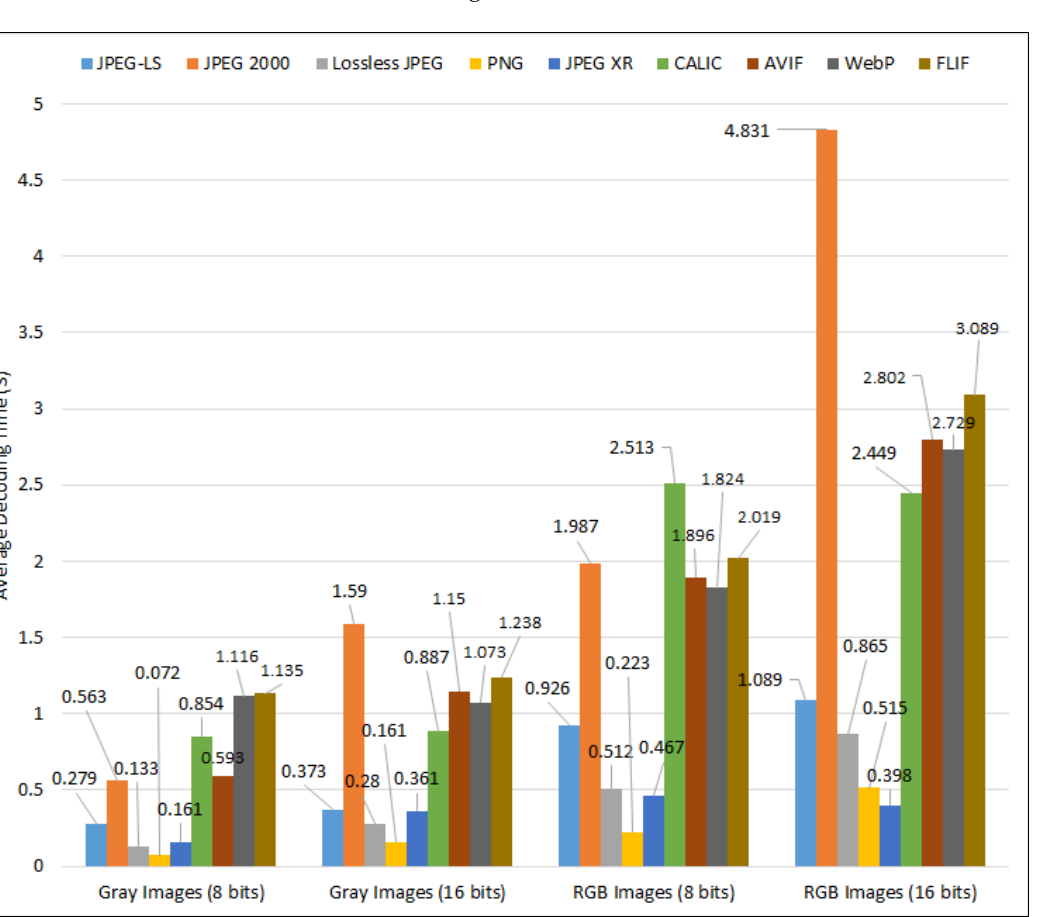
Figure 28. Comparison of average decoding